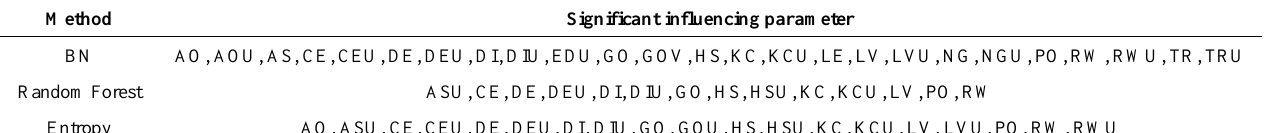
Table 4. The set of significant influencing parameters on PE in undirected networks